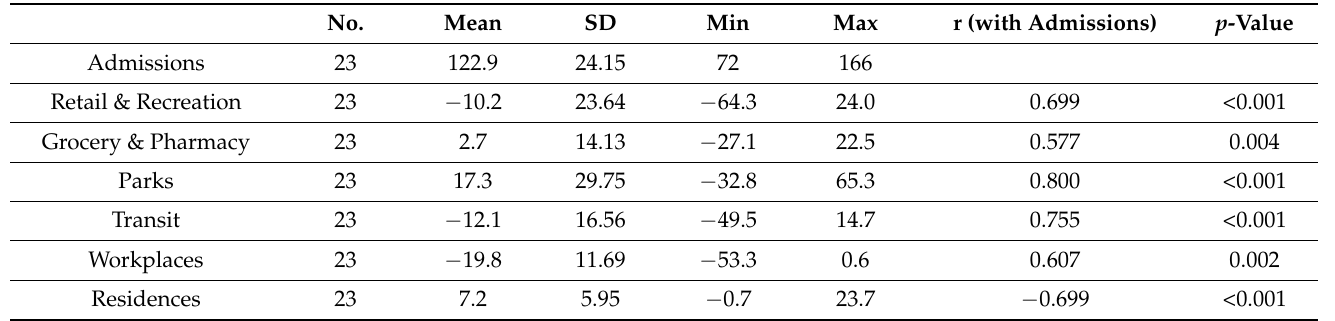
Table 4. Summary of Pearson’s correlation of monthly psychiatric admissions with mean monthly community mobility data (units represent percentage change from